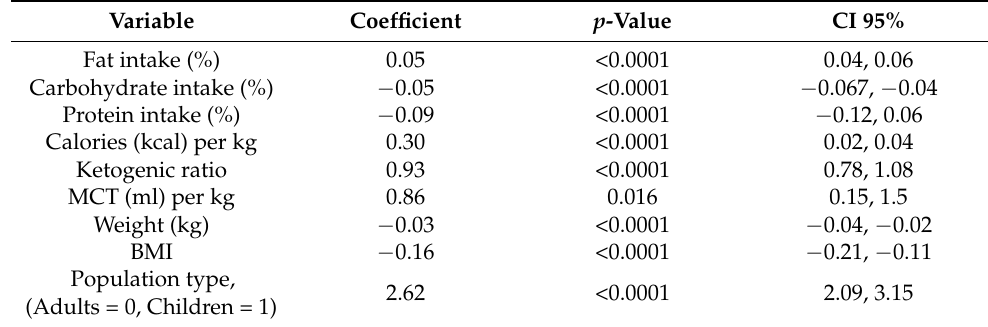
Table 2. Covariate associations with blood ketone levels, mixed-model univariate analysis.